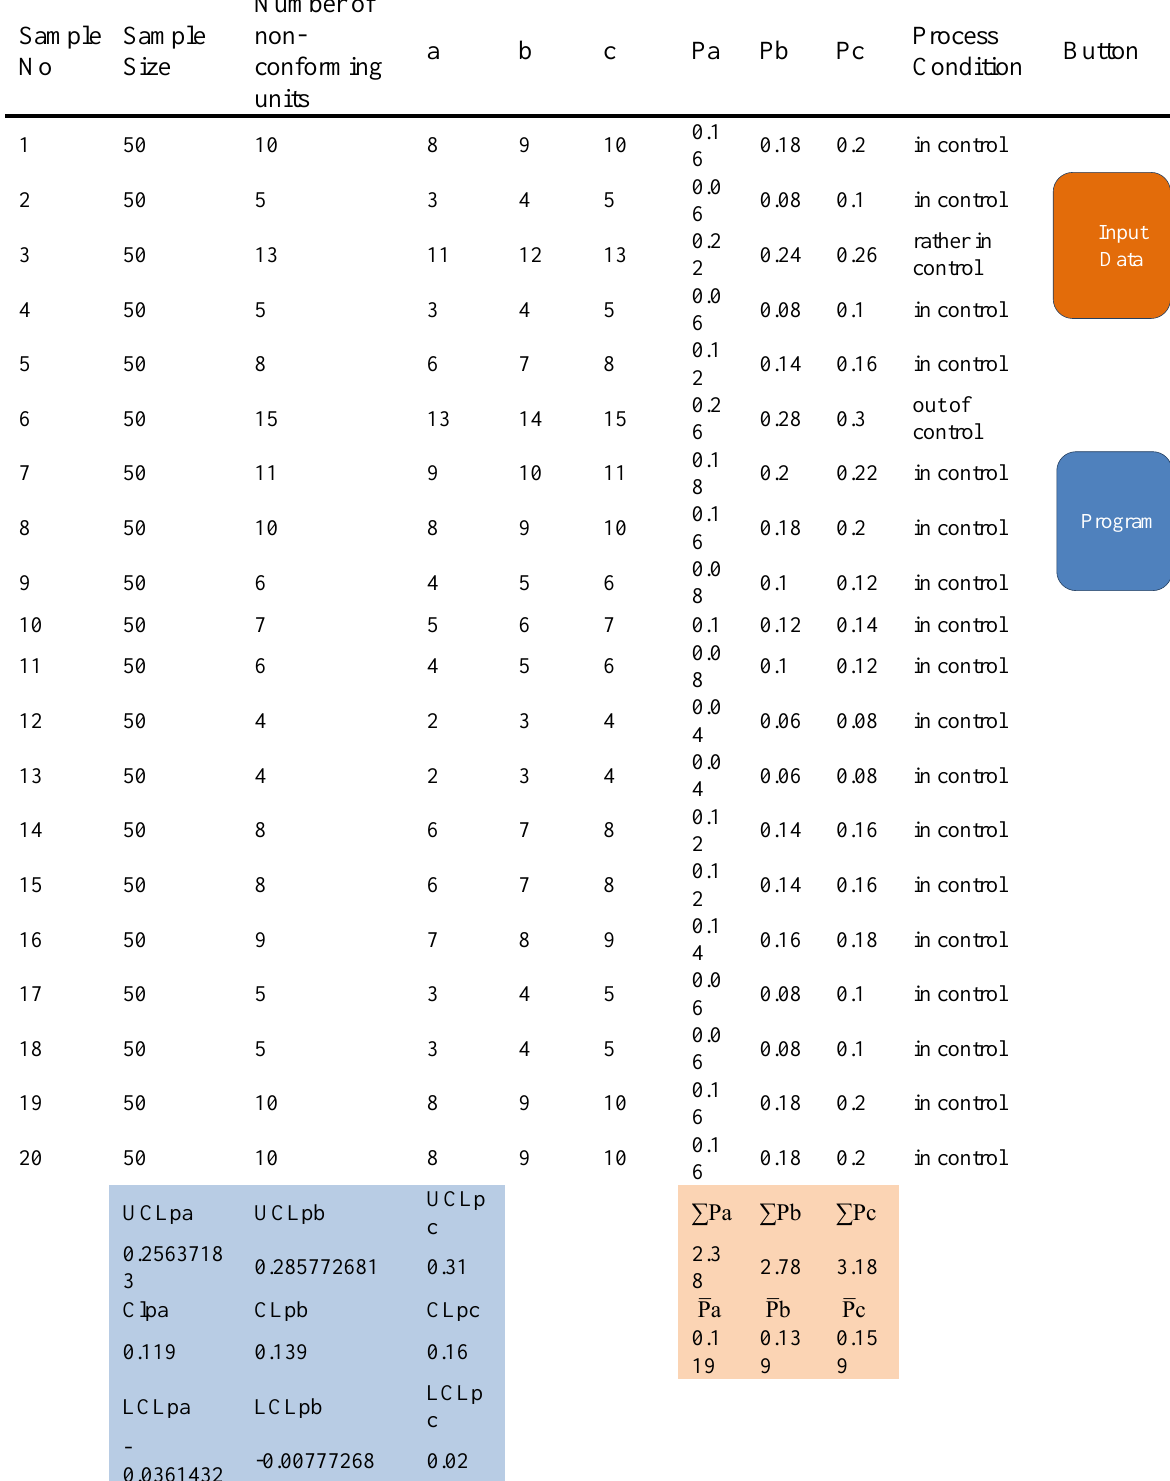
Table 1. P-Control Chart Based on Constant Sample Size for TFN